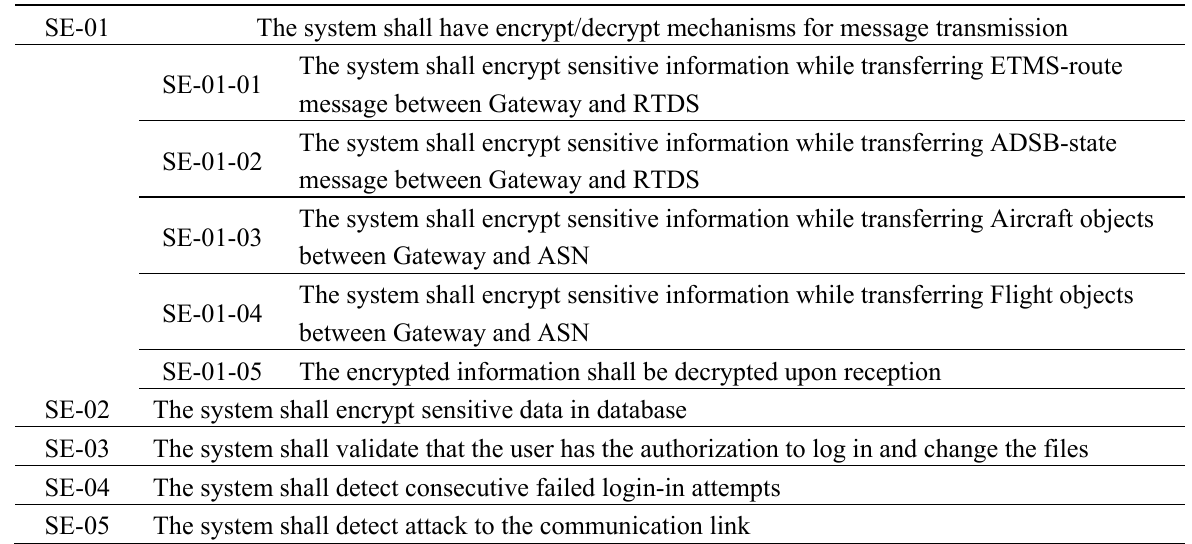
Table 3. ASN Gateway security